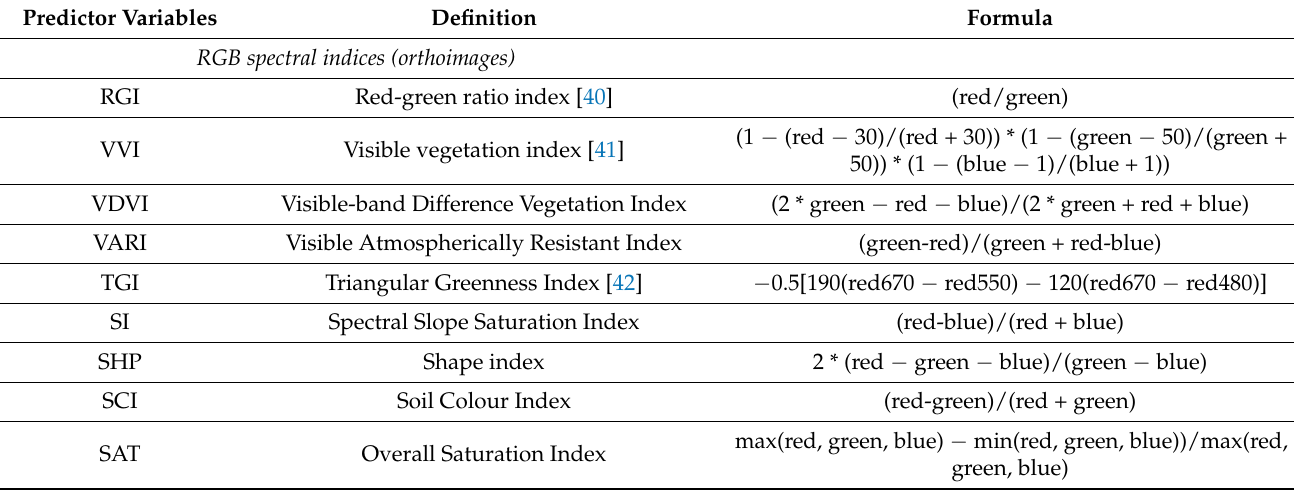
Table 1. Peat bog data set spatiotemporal predictors and ground truth responsive